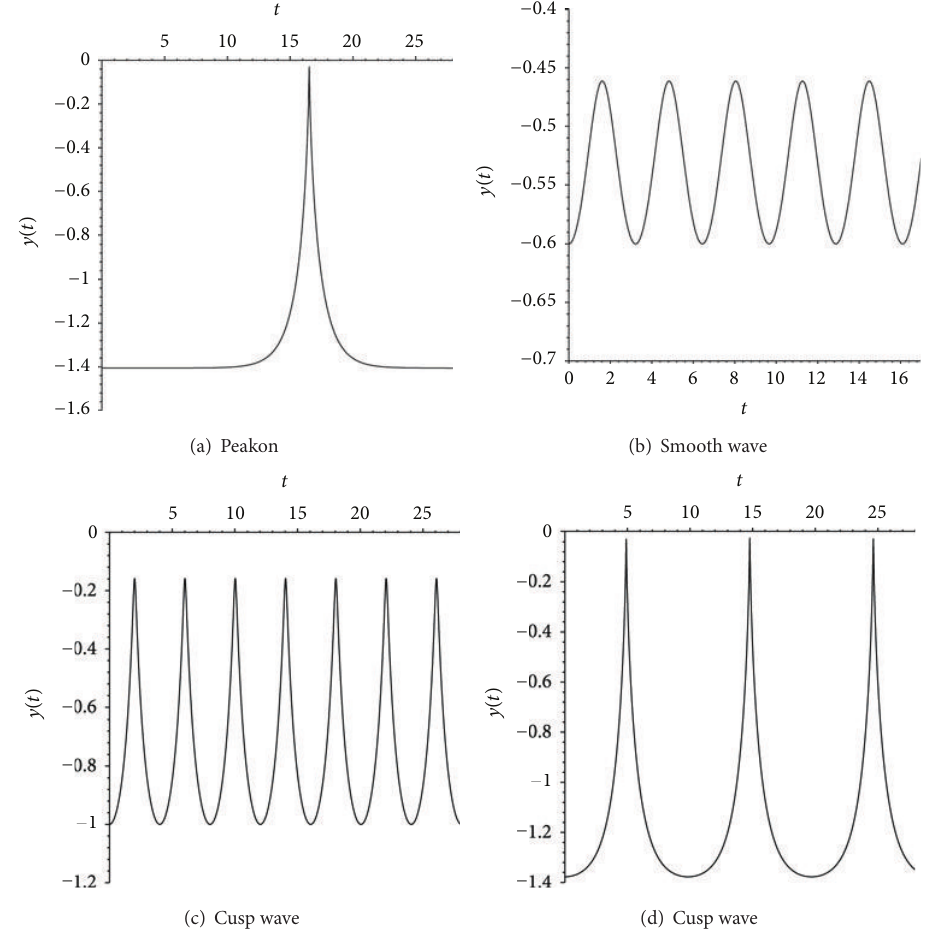
Figure 12: The profiles of pseudo-peakon and periodic cusp wave solutions of